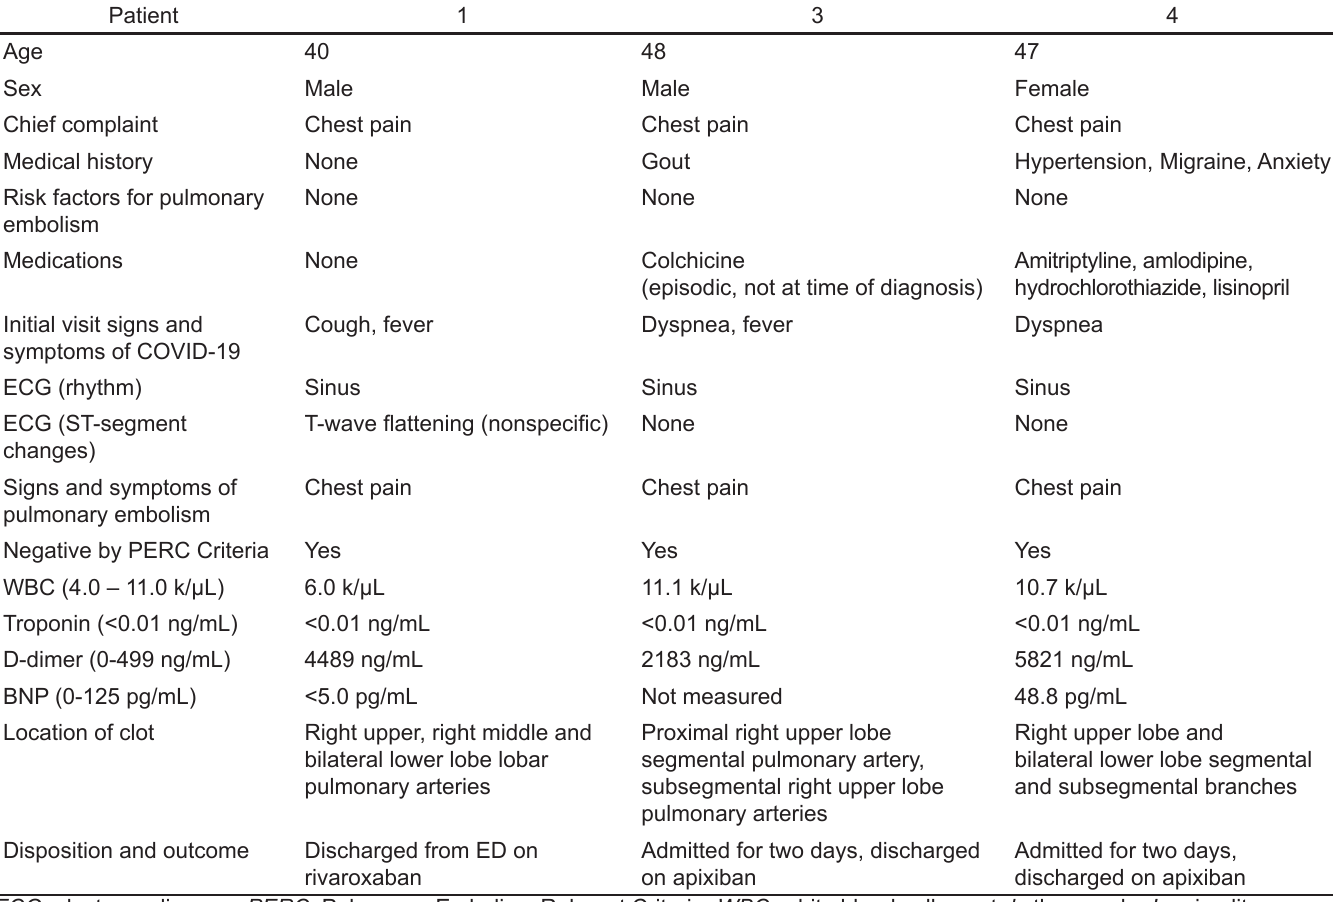
ECG, electrocardiogram; PERC, Pulmonary Embolism Rule-out Criteria; WBC, white blood cell count; k, thousand; µL, microliter; ng, nanogram; mL, milliliter; BNP, B-type natriuretic peptide; pg, picogram; ED, emergency